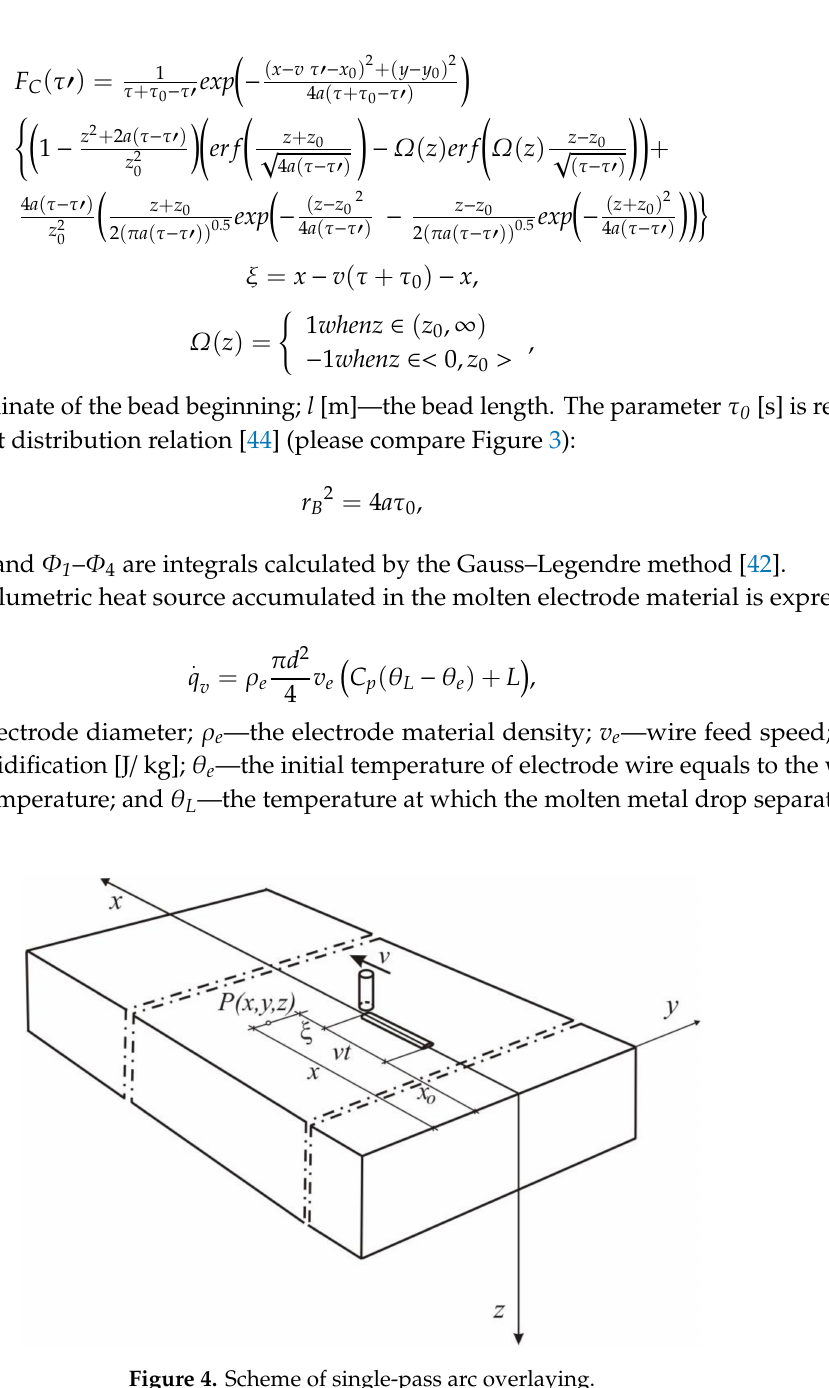
Figure 4. Scheme of single-pass arc